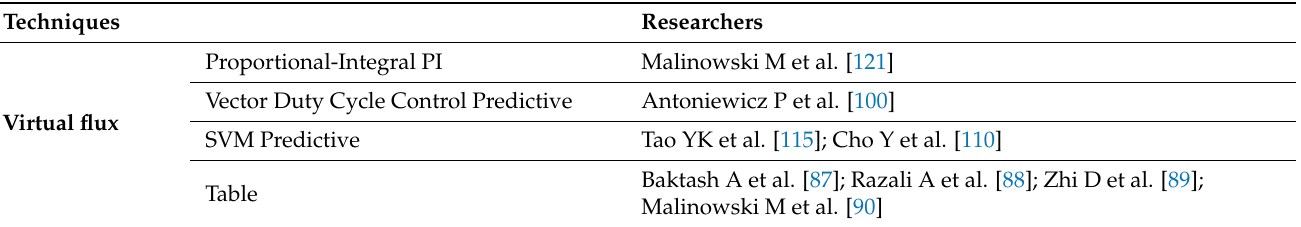
Table 2. Various techniques used for DPC